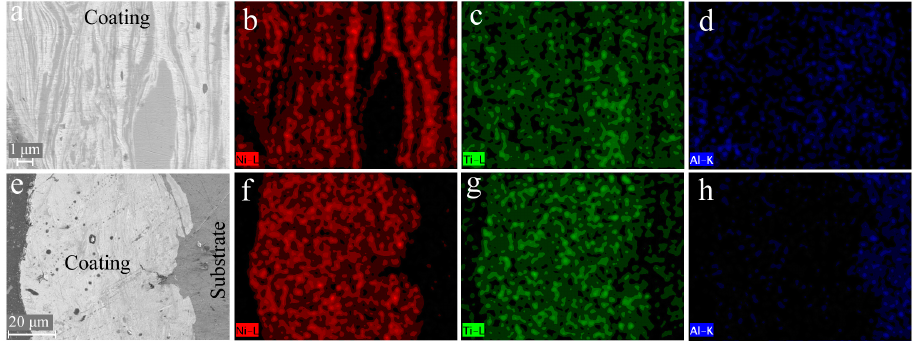
Figure 3. Cross-section SEM images and element mapping of the Ni-Ti coatings obtained by MA: a general view of the microstructure of the coating, ( a ) obtained on the Al-based alloy substrate; ( b ) contents of Ni; ( c ) Ti; ( d ) Al and a general view of the microstructure of the coating; ( e ) obtained on the hypoeutectoid steel substrate, contents of ( f ) Ni; ( g ) Ti; ( h ) Al.